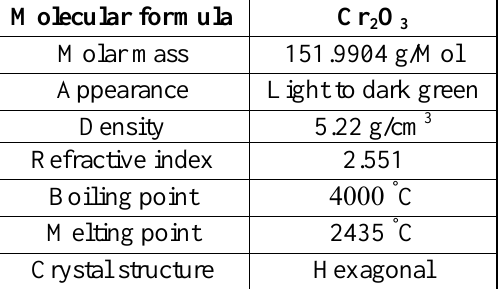
Table 1 : Material properties of Cr